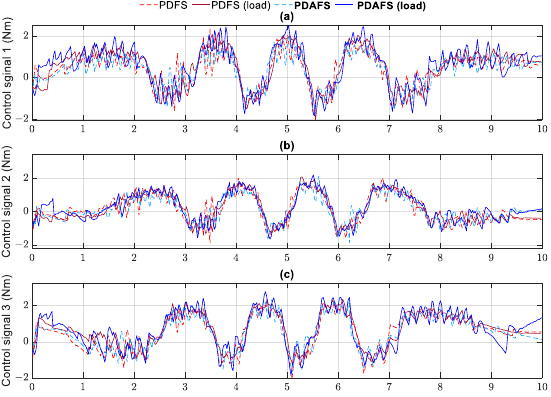
Figure 17. Helix trajectory performance in joint space: ( a ) joint 1; ( b ) joint 2; ( c ) joint 3 and tracking error: ( d ) joint 1; ( e ) joint 2; ( f ) joint 3 in case 2.